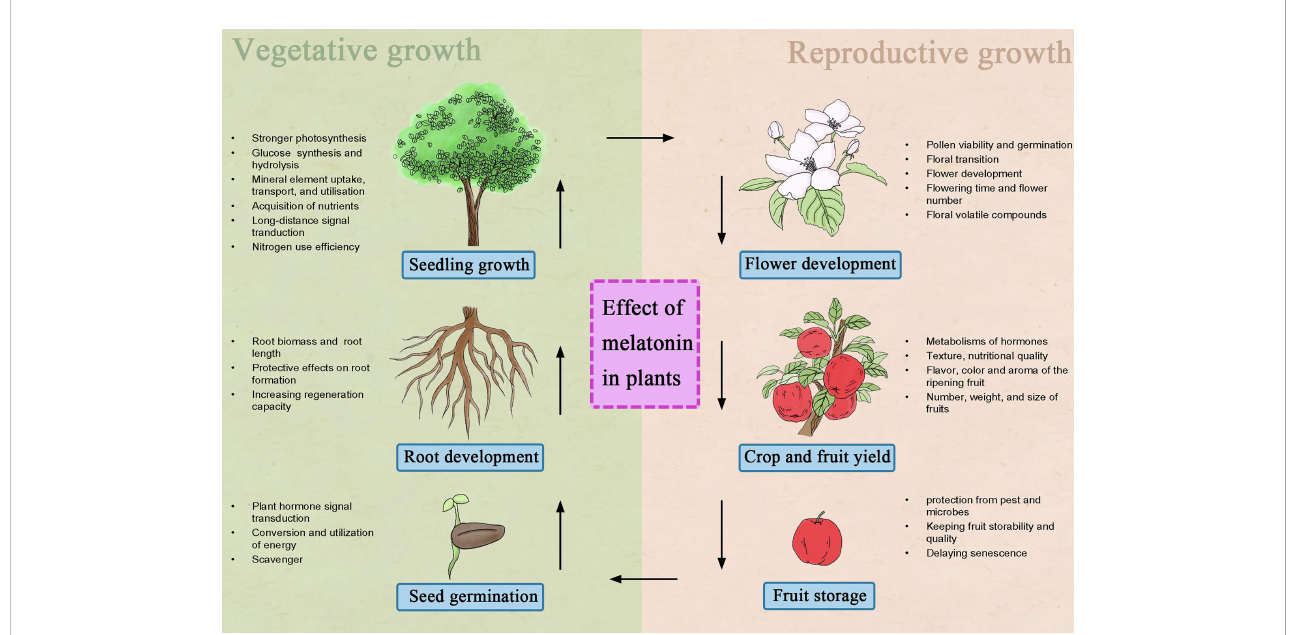
FIGURE 1 Summary of functional melatonin in plant vegetative growth and reproductive